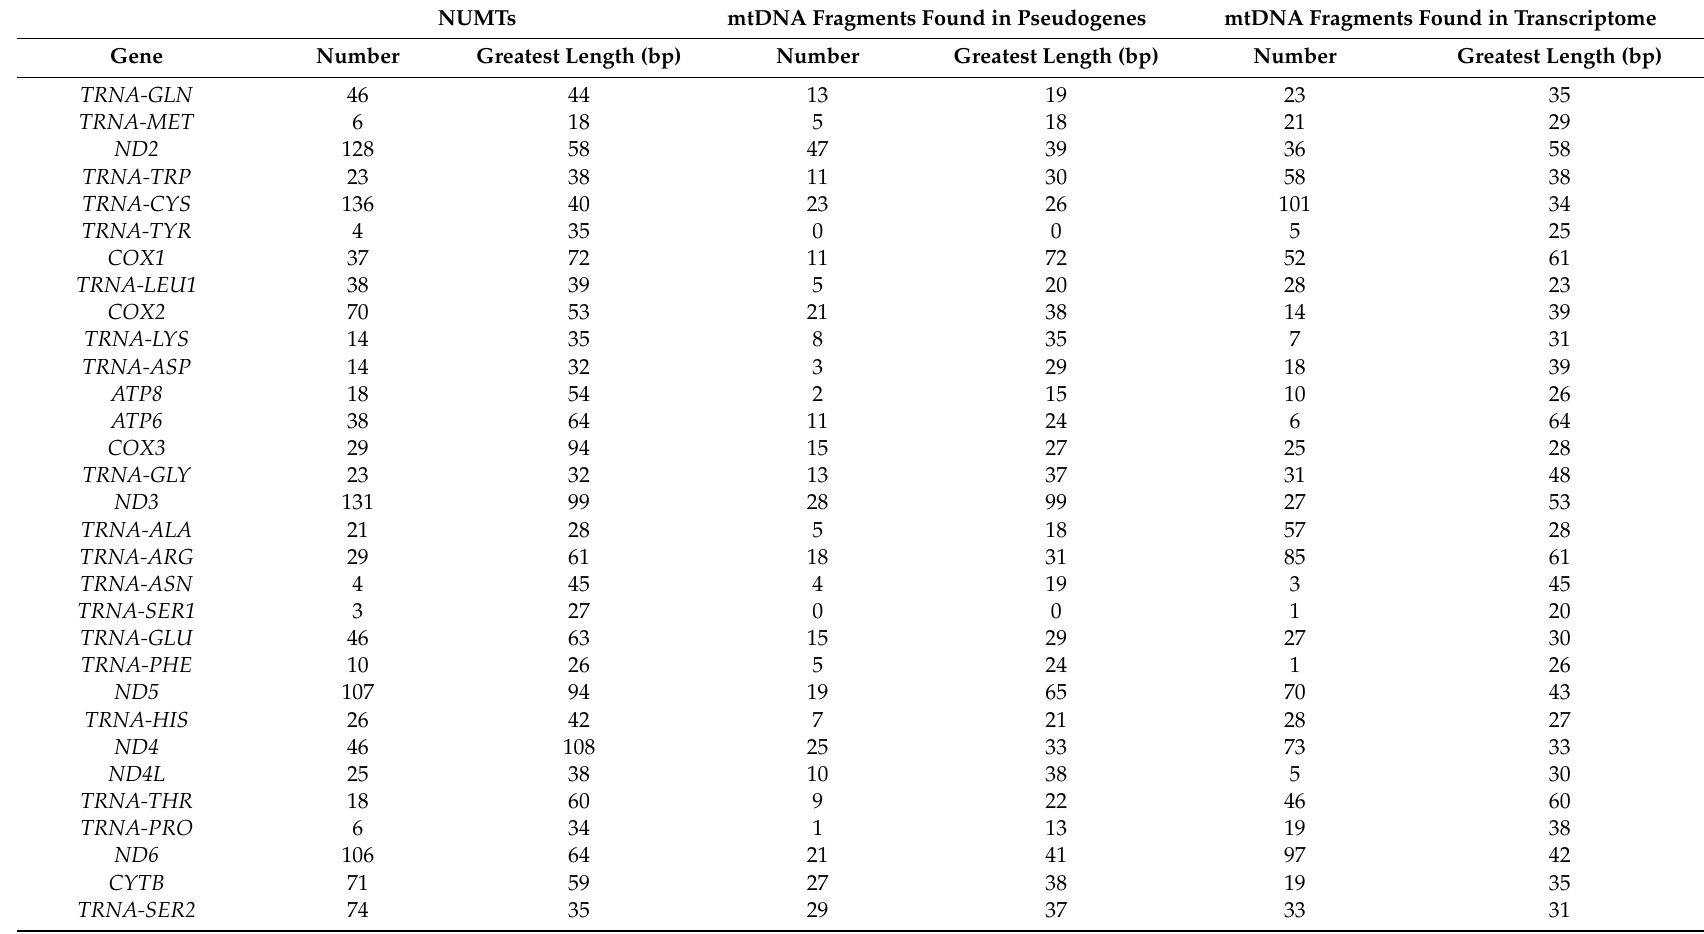
Table 5. The comparison of the number and length of mitochondrial DNA fragments found in the nuclear genome (NUMTs), pseudogenes, and the transcriptome. NUMTs mtDNA Fragments Found in Pseudogenes mtDNA Fragments Found in Transcriptome Gene Number Greatest Length